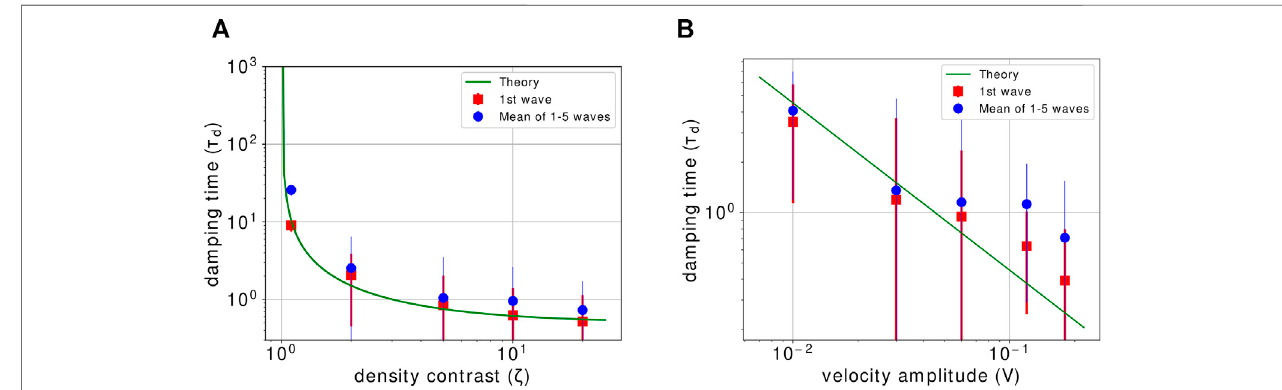
FIGURE7| Dampingtimeforthepropagatingwaveasafunctionofdensity contrast (A) andvelocityamplitude (B) .Thegreenlinerepresentsthetheoreticalmodel for the damping time Eq. 27 . Red squares are the calculated damping time for the fi rst wave front. Blue dots are the average of the fi rst 5 waves fronts.